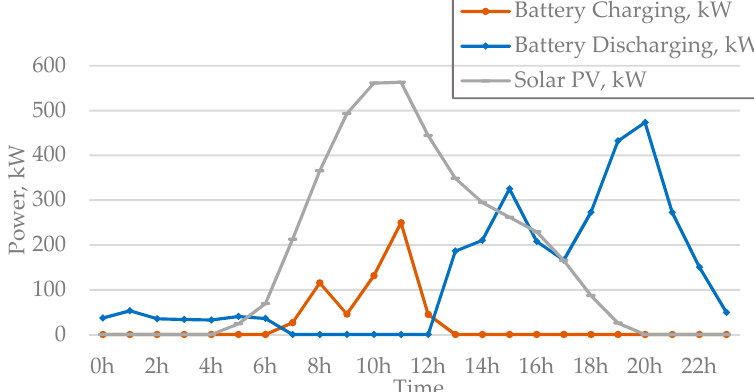
Figure 3. Charging and discharging powers of battery.